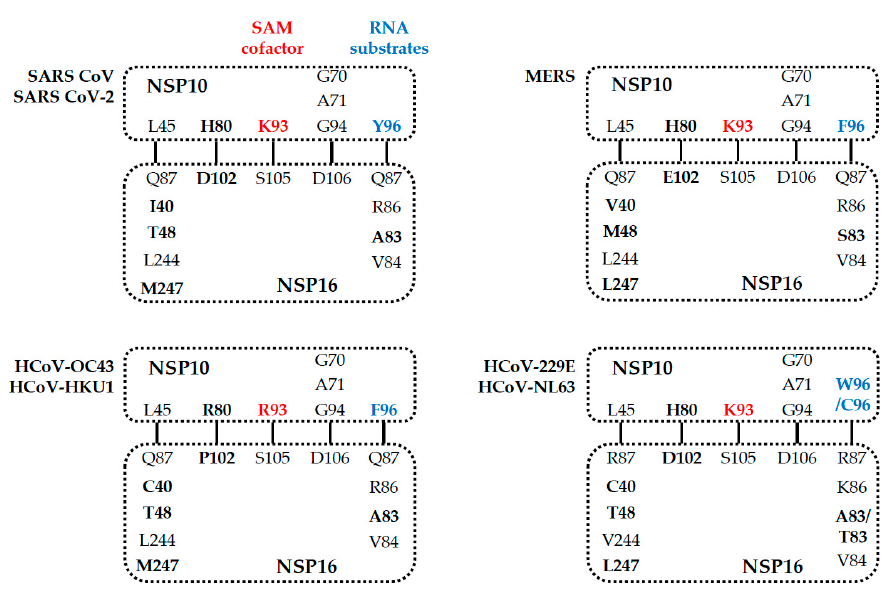
Figure 4. Overall fold of the SARS-CoV-2 NSP10–NSP16 complex. NSP10 is shown in turquoise and NSP16 in gold. PDB ID: 7jyy.1.